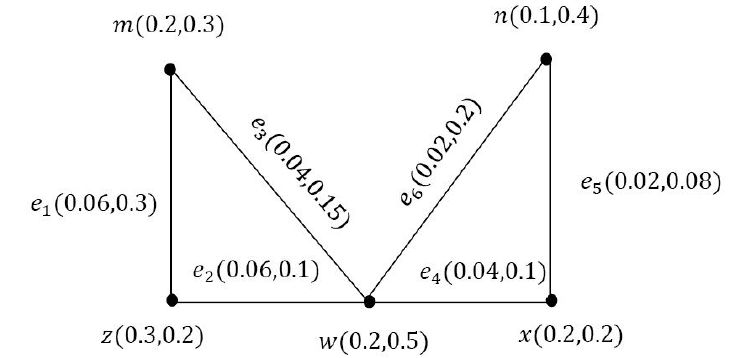
Figure 11. Product vague graph ζ with total edge dominating